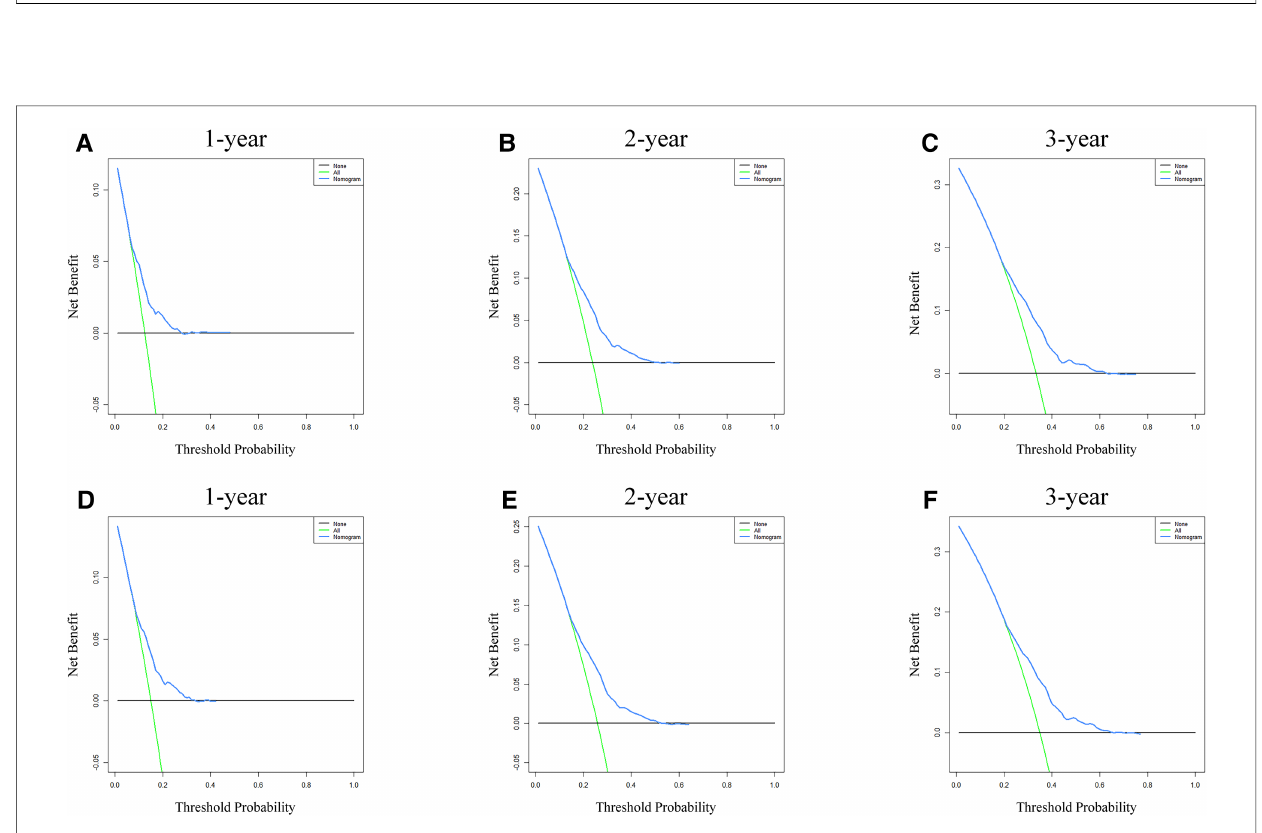
FIGURE 4 Nomogram DCA for survival prediction of LSCC patients. ( A – C ) 1-, 2- and 3-year survival bene fi t in training cohort patients. ( D – F ) 1-, 2- and 3-year survival bene fi t in validation cohort patients. DCA, decision curve analysis; LSCC, lung squamous cell